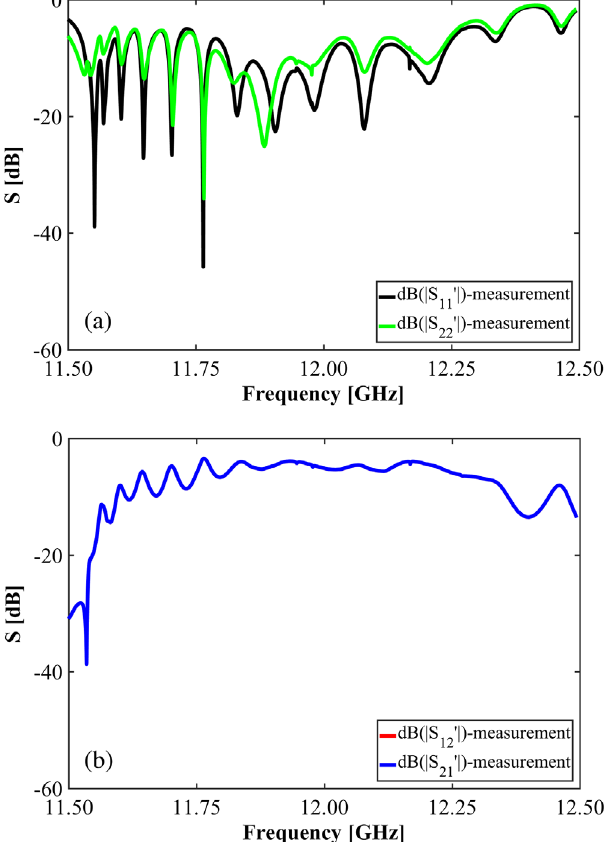
FIG. 24. Comparisons between measured (a) S 0 11 and S 0 22 , (b) S 0 12 and S 0 21 for the full-assembly structure with two power